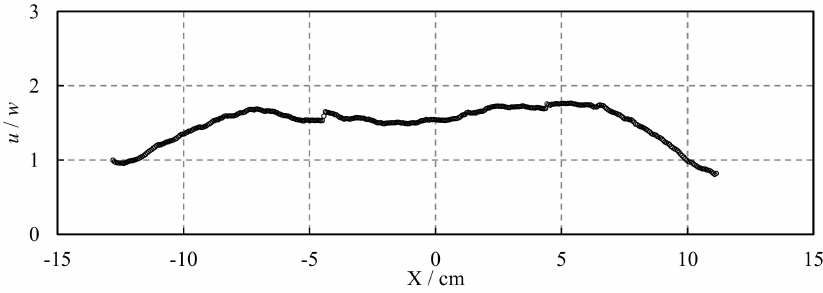
Figure 8. Variation of the ratio of u / w along the X direction when s = 0.5 cm and f = 3 Hz.